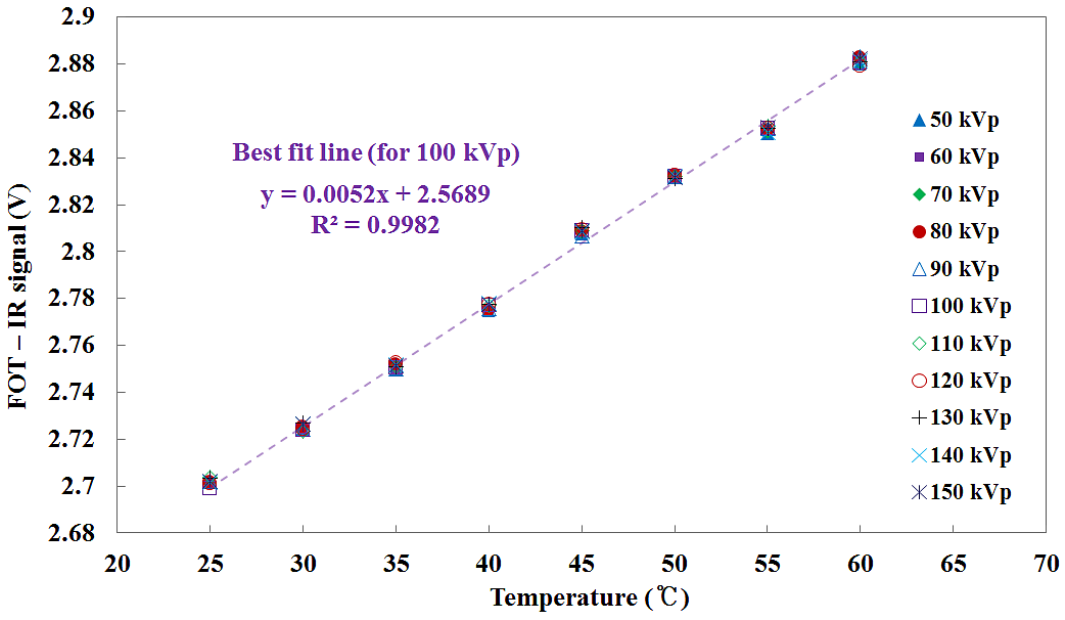
Figure 10. Relationship between the temperature of water and the IR signal measured by the FOT.